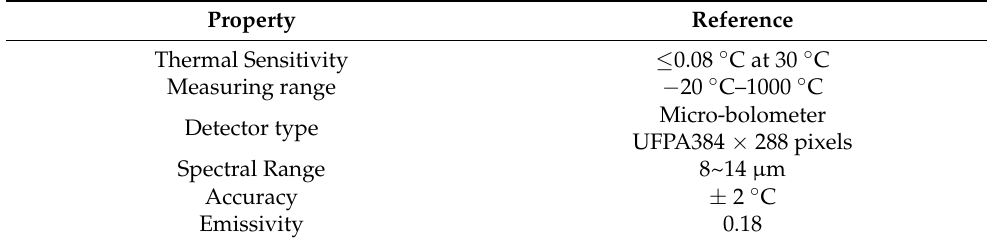
Table 4. ThermoPro-TP8 specifications.